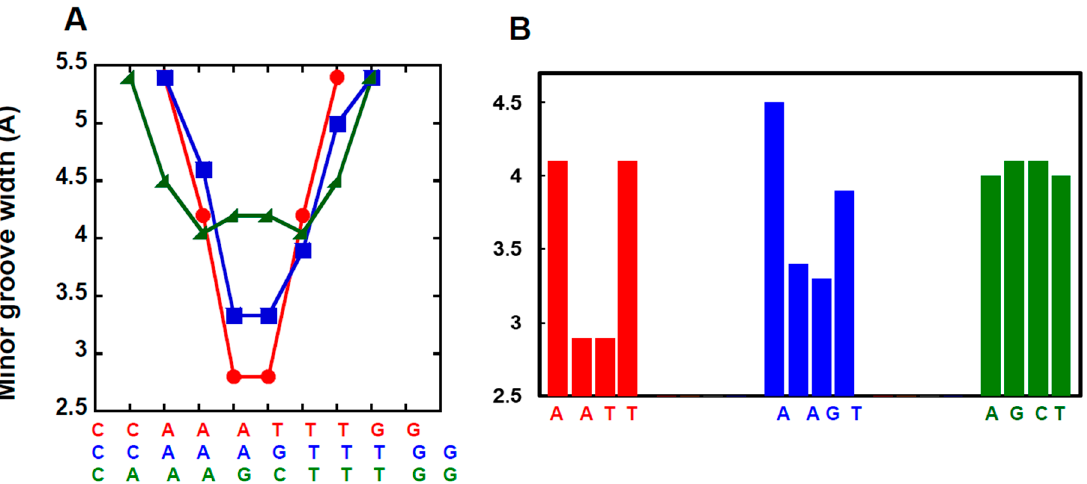
Figure 4. ( A ) MGW vs. DNA sequences used in this work; ( B ) Column plot of MGW for the central target sequence calculated from the online algorithm of Rohs and coworkers [88].